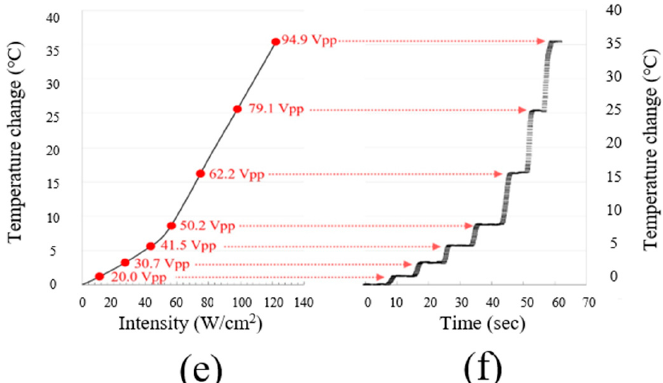
Figure 5. Temperature calibration using optic fibers. ( a ) Schematic illustration of temperature measurement; ( b ) experi- mental setup including two optic fibers and a control box; ( c ) two fibers were embedded in chicken breasts, and only the therapeutic transducer was operated to calibrate the thermal effects; ( d ) a cross-sectional view after HIFU treatment. Le- sion obtained ex vivo from chicken by HIFU. Results of temperature calibration; ( e ) the temperature change over the intensity; and ( f ) the temperature change over time at given voltages.